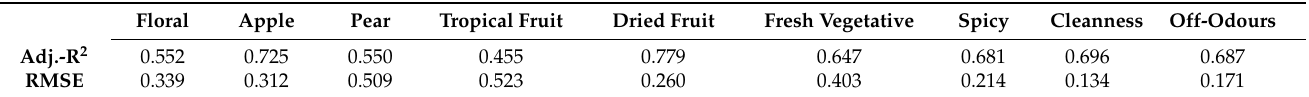
Table 1. Quality index (Adj.-R 2 and RMSE) of the PCR for olfactory descriptors on aroma compounds. Floral Apple Pear Tropical Fruit Dried Fruit Fresh Vegetative Spicy Cleanness Off-Odours Adj.-R 2 0.552